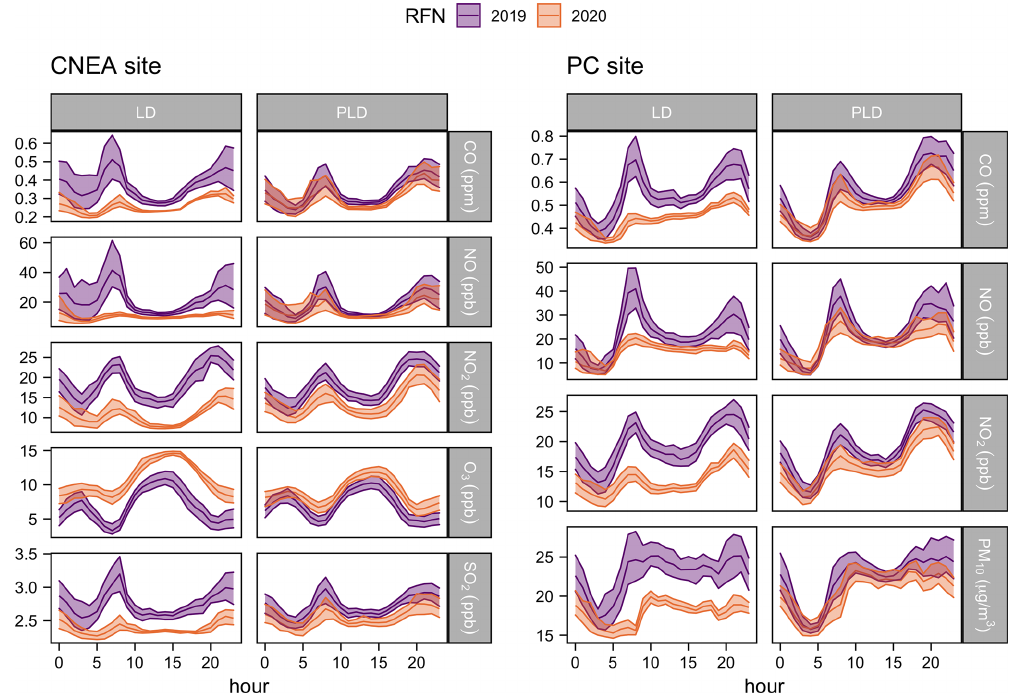
Figure 7. Mean diurnal cycle for different pollutants for the LD, PLD, and MAM2019 periods, with meteorological normalization for both sites.